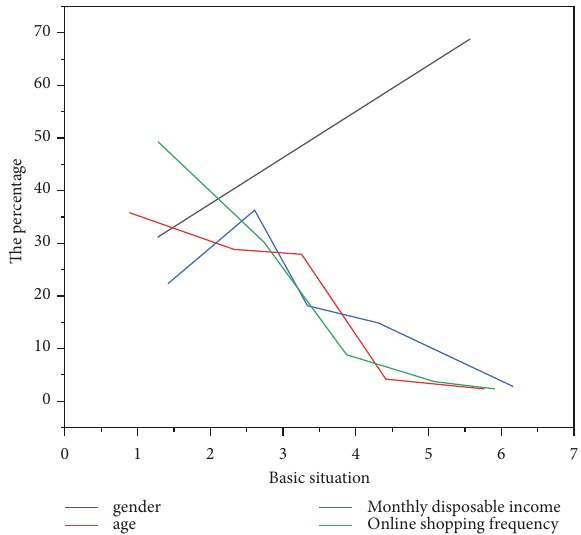
Figure 9: Descriptive statistical analysis results of